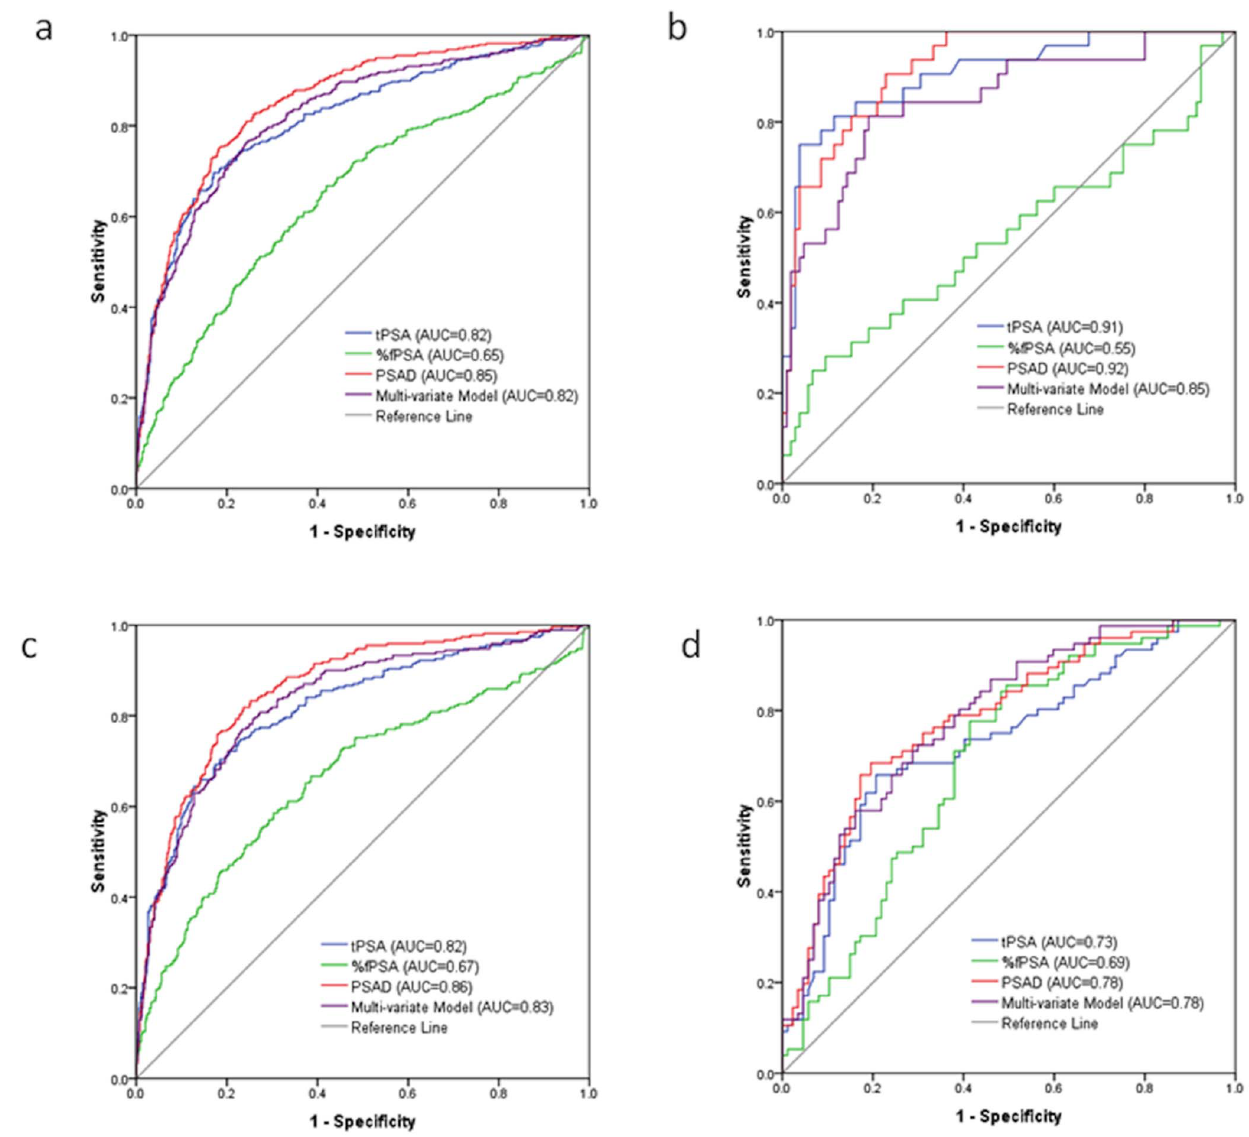
Figure 5. ROC of tPSA, %fPSA and PSAD for predicting the result of prostate biopsy for Gleason Score $ 7 PCa vs. Gleason Score , 7 and non-PCA in different age groups. (a)All study population: AUC-tPSA vs. AUC-%fPSA (P , 0.001), AUC-PSAD vs. AUC-tPSA(P=0.05), AUC- model vs. AUC-tPSA(P . 0.05); (b) Age # 60 yr, AUC-tPSA vs. AUC-%fPSA (P . 0.05), AUC-PSAD vs. AUC-tPSA(P . 0.05), AUC-model vs. AUC-tPSA(P . 0.05); (c) Age 61–80 yr, AUC-tPSA vs. AUC-%fPSA (P , 0.001), AUC-PSAD vs. AUC-tPSA(P . 0.05), AUC-model vs. AUC-tPSA(P . 0.05); (d) Age $ 81 yr, AUC-tPSA vs. AUC-%fPSA (P . 0.05), AUC-PSAD vs. AUC-tPSA(P . 0.05), AUC-model vs. AUC-tPSA(P . 0.05).